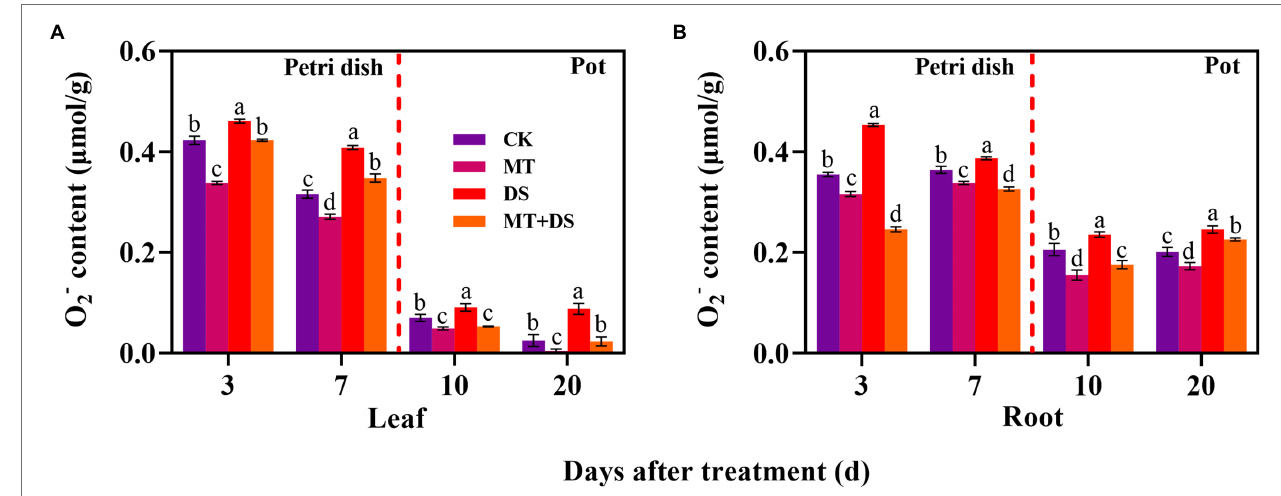
FIGURE 10 | In Petri dish, 20 μ M MT was used as the optimal priming treatment for triticale seeds priming (MT), 0 μ M MT as normal treatment (CK), 10% PEG as drought treatment (DS), and 20 μ M MT + 10% PEG treatment (MT+DS). In pot, 20 μ M MT was used as the optimal priming treatment for triticale seedlings, unprimed +70–75% relative water content as CK, primed +70–75% relative water content as MT, unprimed +40–45% relative water content as DS, and primed +40–45% relative water content as MT+DS. (A) O 2 − content of triticale seeds germinated in Petri dishes on 3 rd and 7 th days and potted seedling leaves on 10 th and 20 th ; and (B) O 2 − content in radicle of triticale seeds germinated in Petri dish on 3 rd and 7 th day and seedling roots on 10 th and 20 th d. For each trait, bars with the same letter are not significantly different ( p < 0.05). Different lower letters indicate significant differences among the treatments ( p < 0.05). Data shown are the averages ± SE ( n = 6 in A,B ).